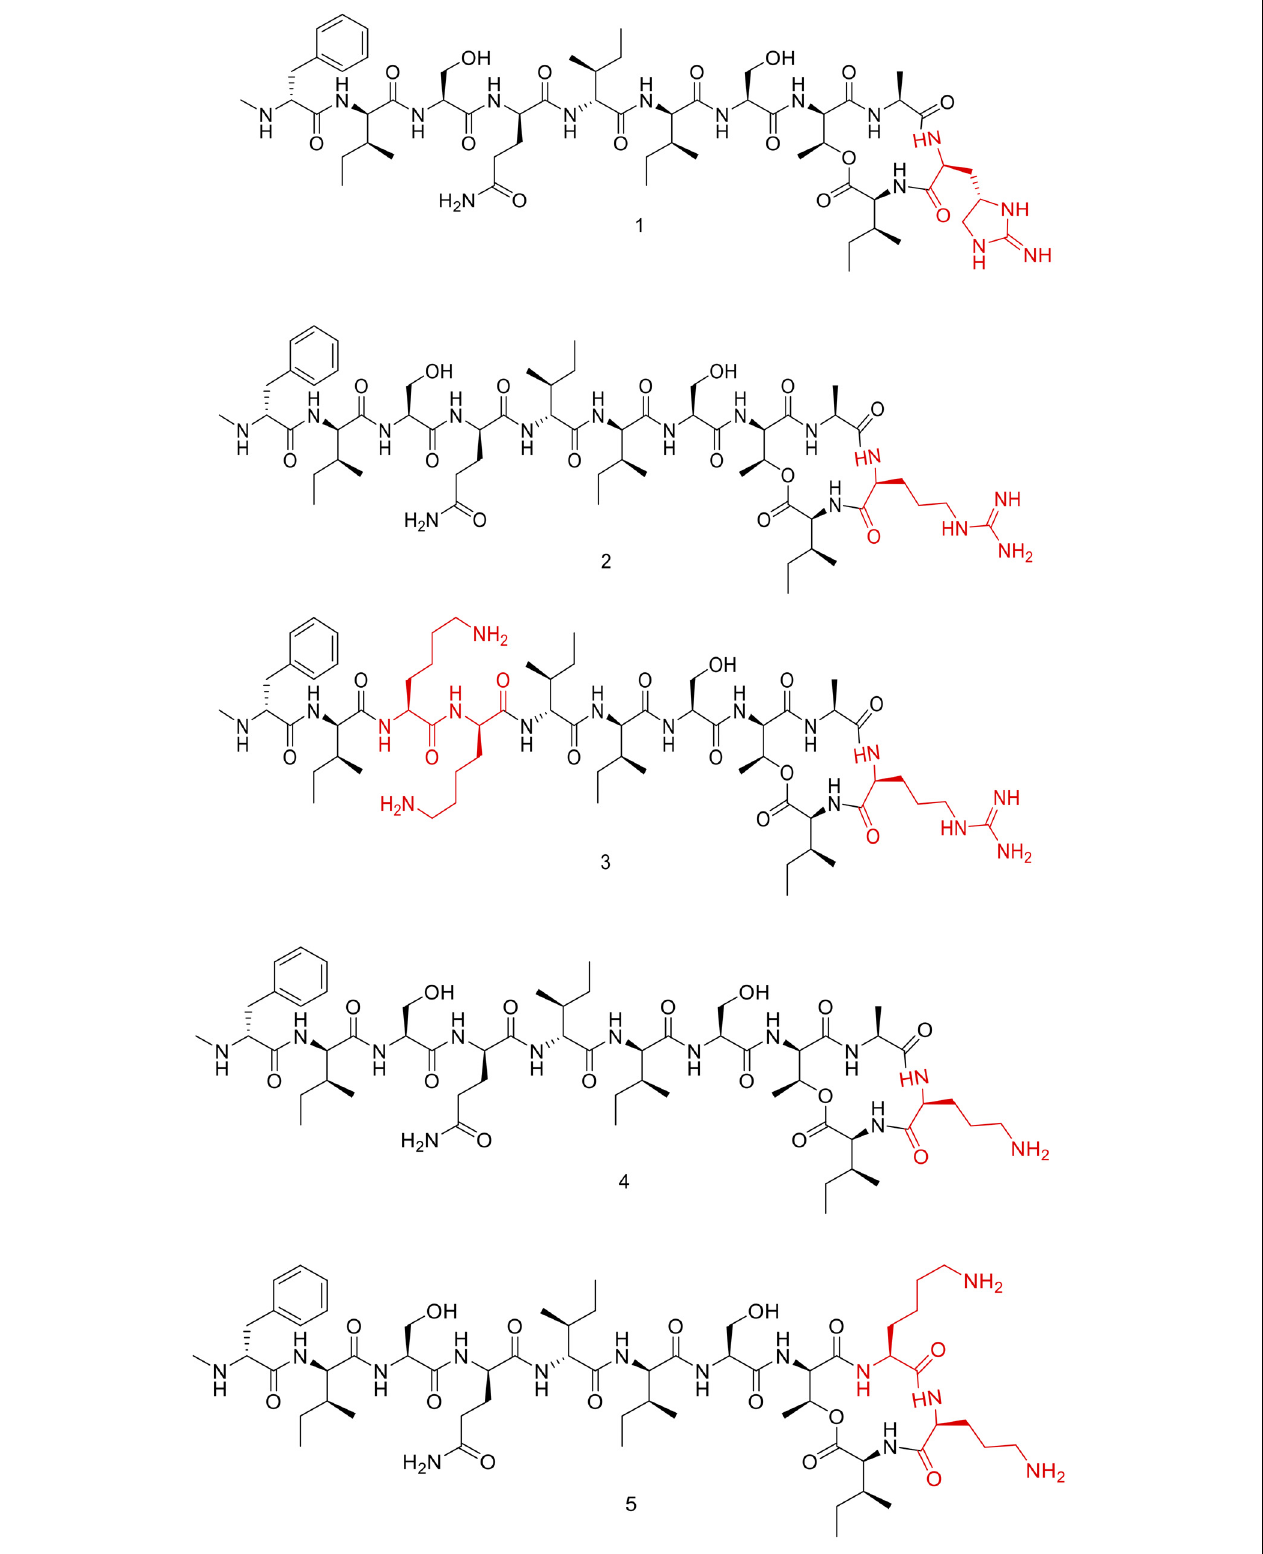
FIGURE 1 | Chemical structure of Teixobactin and derivatives (1, 2, 3, 4, and 5).